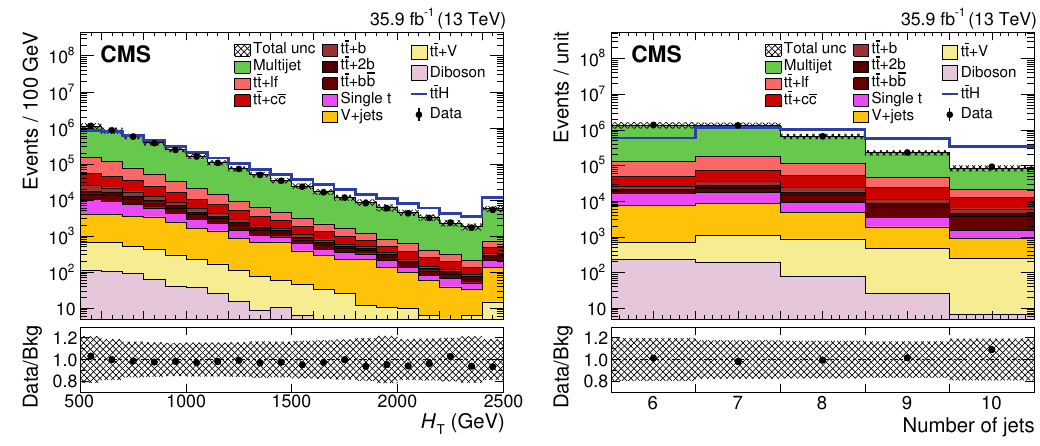
Figure 2 . Distribution in H T (left) and jet multiplicity (right) in data (black points) and in simulation (stacked histograms), after implementing the preselection. The simulated backgrounds are (cid:12)rst scaled to the integrated luminosity of the data, and then the simulated QCD multijet background is rescaled to match the yield in data. The contribution from ttH signal (blue line) is scaled to the total background yield (equivalent to the yield in data) to enhance readability. The hatched bands re(cid:13)ect the total statistical and systematic uncertainties in the background prediction, prior to the (cid:12)t to data, which are dominated by the systematic uncertainties in the simulated multijet background. The last bin includes event over(cid:13)ows. The ratios of data to background are given below the main panels.